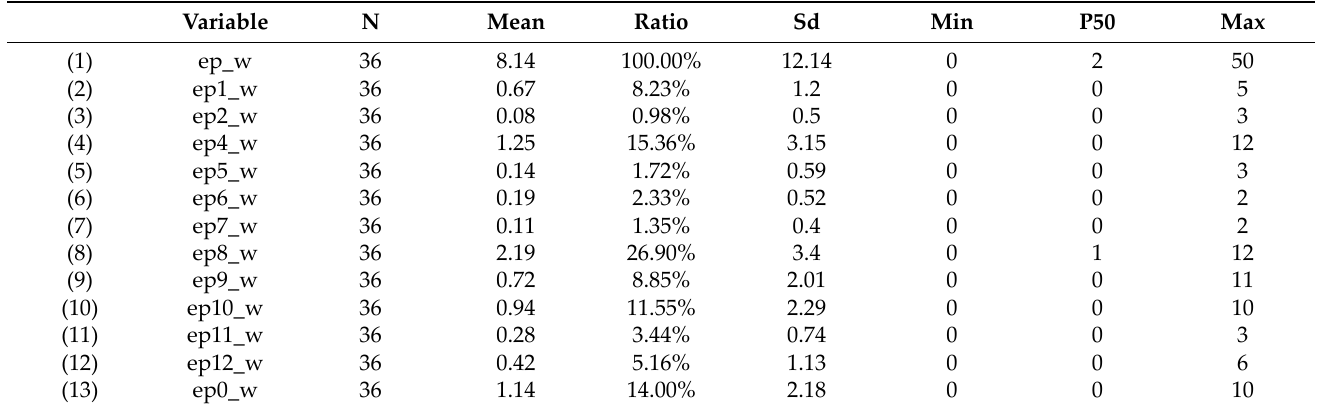
Table 3. Results of environment level‑2 subdimension analysis on social media.